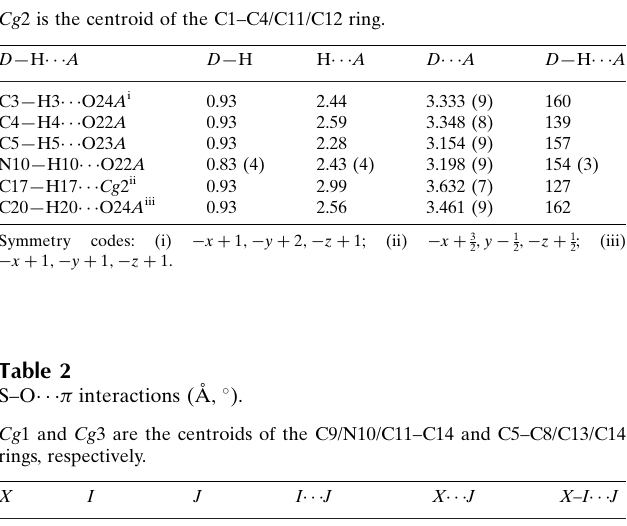
Hydrogen-bond geometry (A˚ , (cid:4)